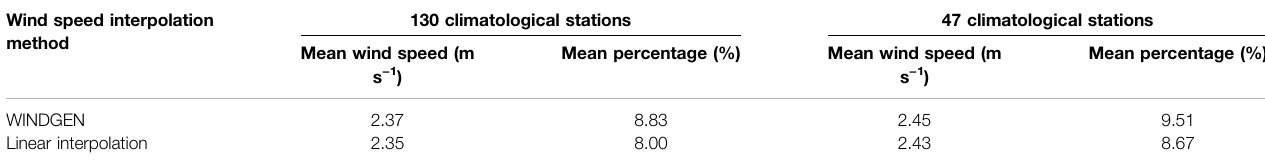
TABLE7| Meanwindspeedandpercentageofwindspeedsgreaterthanthethresholdwindspeed(5 m s − 1 )estimatedbytheWINDGENandLinearinterpolationmethods. Wind speed interpolation